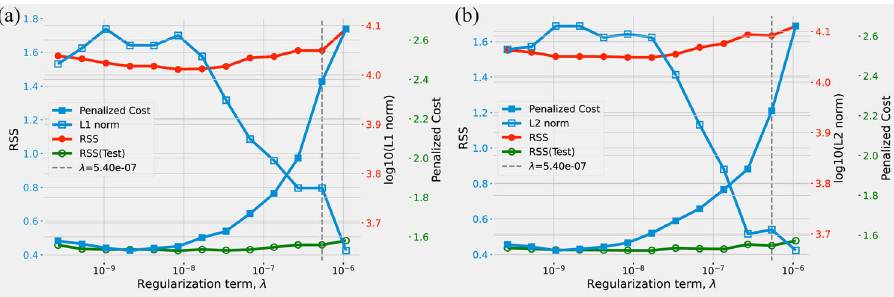
Fig. 4 Convergence sequences of the regularization strategy. Automatically tuning of regularization term for regularization processes using ( a ) L1 norm and ( b ) L2